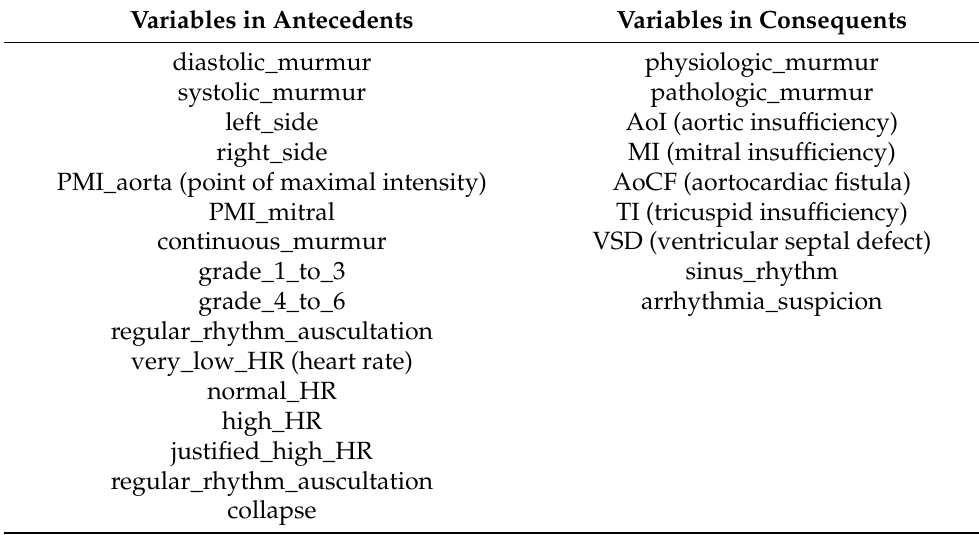
Table 1. Previous definitions subsystem (initial input data and conclusions/ask for more